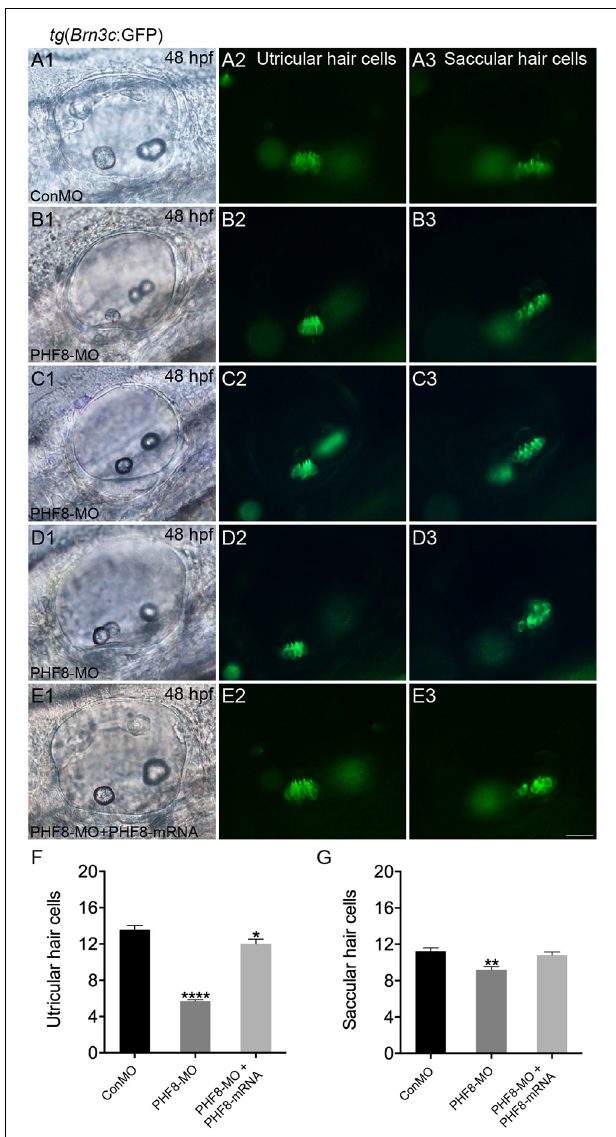
FIGURE 8 | The requirement of PHF8 for hair cells in the inner ear. (A–D) Representative images of GFP (green) in the utricle and saccule of control embryo (ConMO; A1–A3 ), PHF8 morphant (PHF8-MO; B1–B3 , C1–C3 , D1–D3 ), and PHF8-MO co-injected with PHF8-mRNA embryos (PHF8-MO + PHF8-mRNA; E1–E3 ) at 48 hpf. Hair cells were assessed with GFP visualization in transgenic line tg ( Brn3c :GFP). (F–G) Quantification of the numbers of hair cells in the utricle and saccule of the inner ear for each experimental condition at 48 hpf. * p < 0.05, ** p < 0.01, **** p < 0.0001 vs. the ConMO group. Data are presented as means ± SEM ( n = 16 embryos, per each). Optical appearances elucidate lateral visions; anterior is on the left. Scale bar, 25 µ